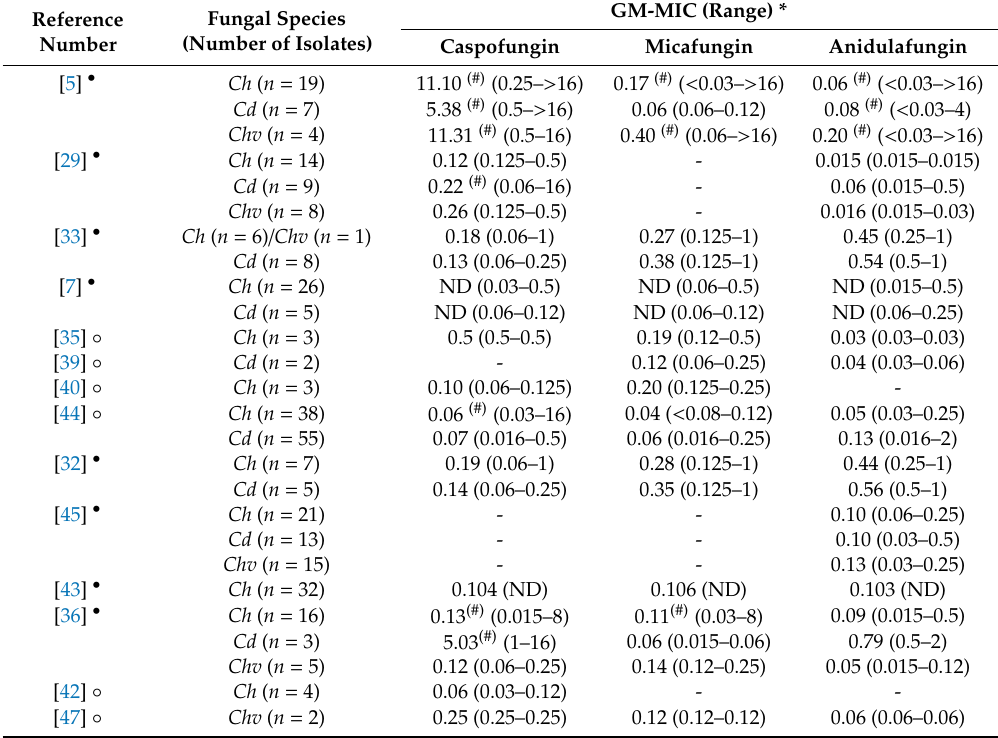
Table 5. Literature review on the antifungal susceptibility of di ff erent isolates of the C. haemulonii complex to